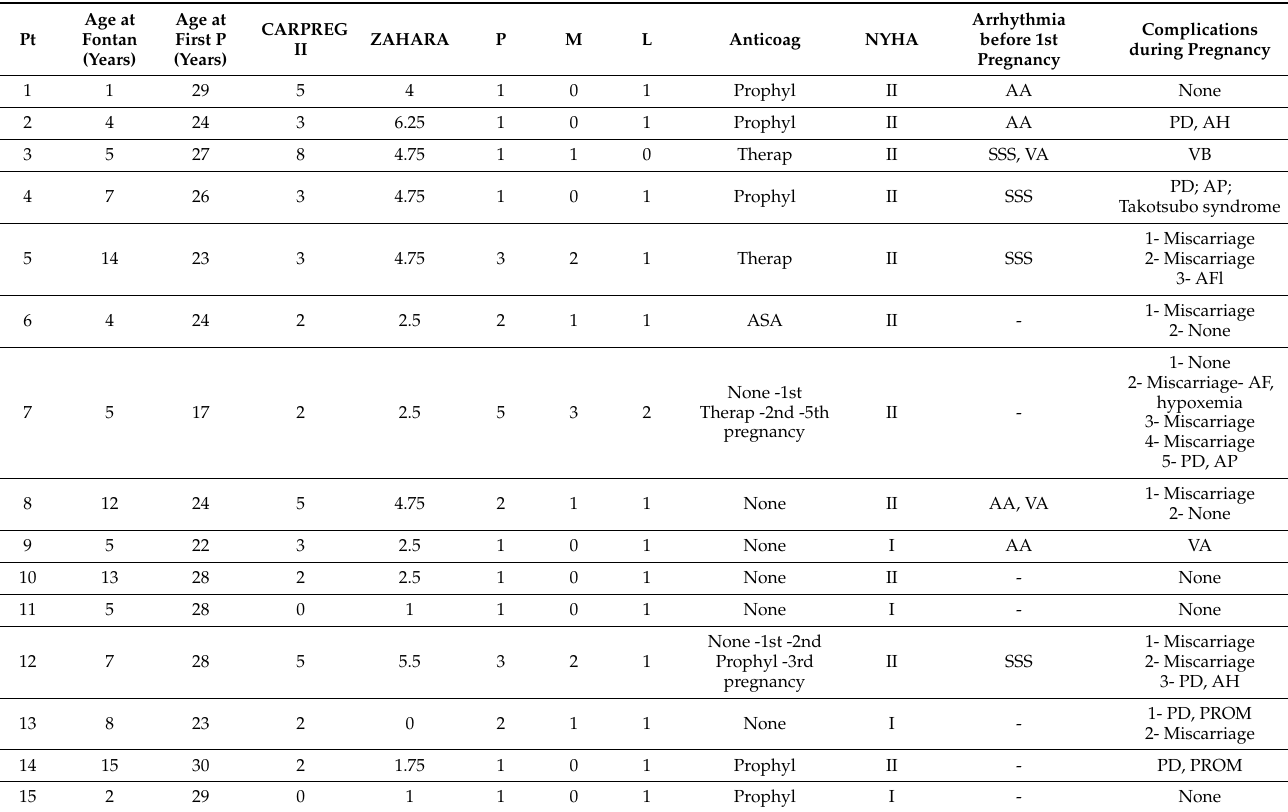
Table 3. Maternal cardiovascular and obstetrical